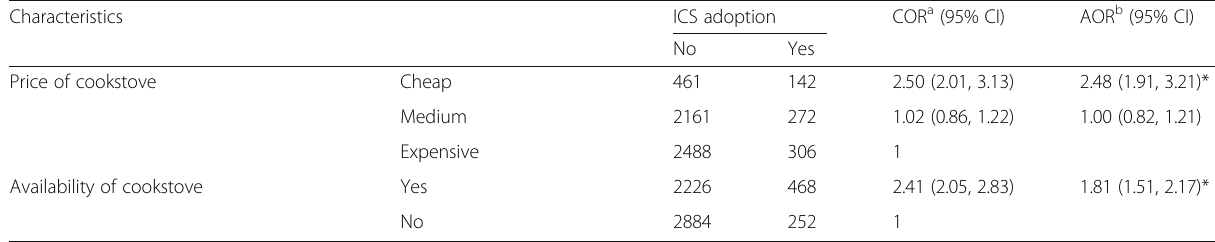
Table 3 Logistic regression analyses describing the associations between ICS adoption and possible predictor variables in Northwest Ethiopia, May 2018 ( n = 5830) (Continued) Characteristics ICS